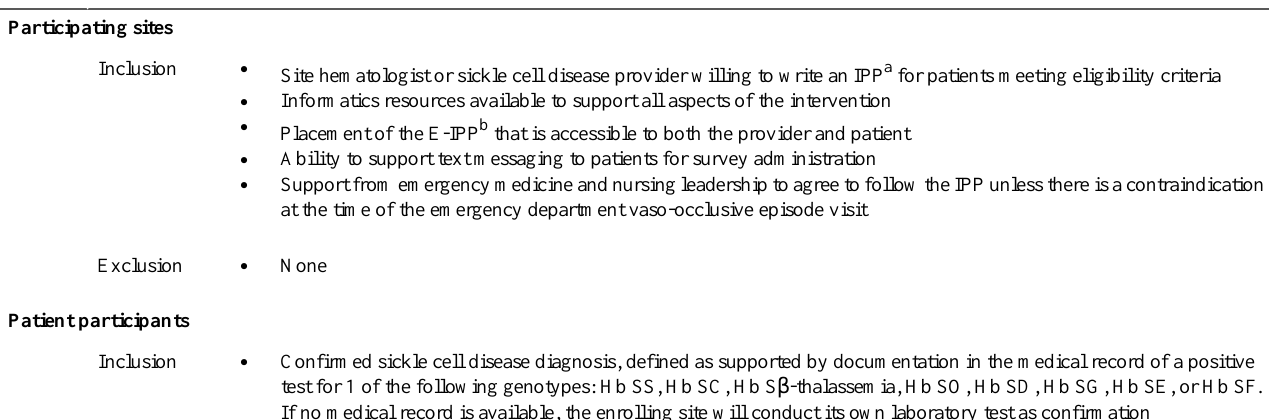
Table 3. Eligibility criteria. CriteriaEntity Participating